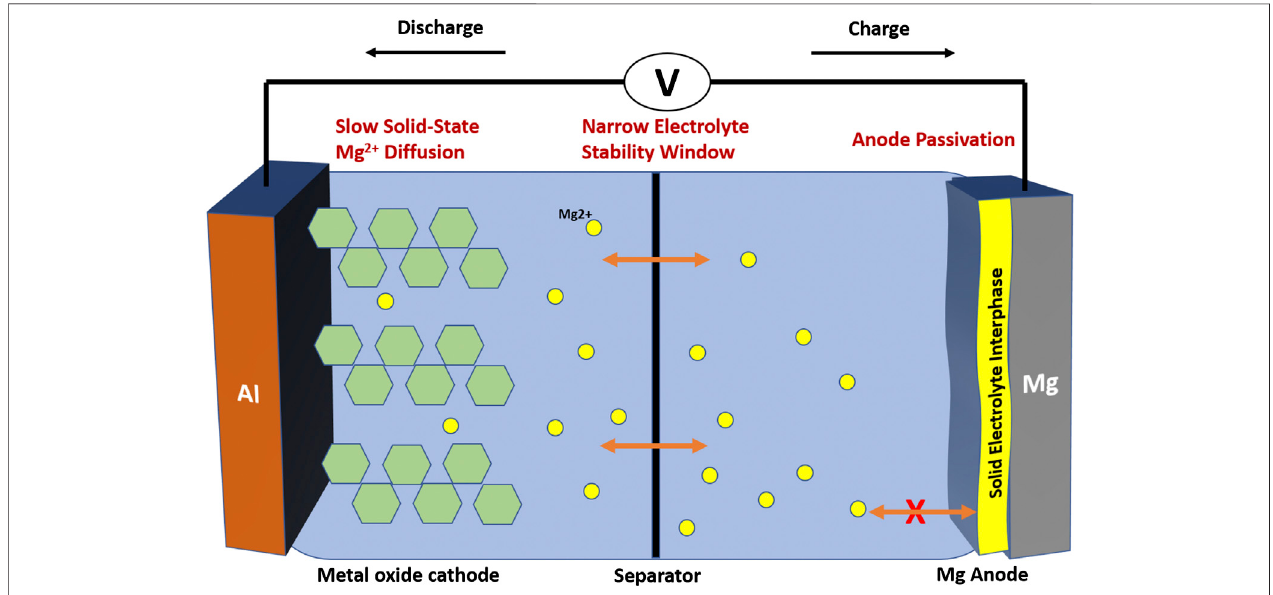
FIGURE 1 | Schematic of standard Mg-ion battery and the central three challenges facing researchers. 1) Slow solid-state diffusion 2) Narrow electrolyte stability window. 3) Anode passivation.